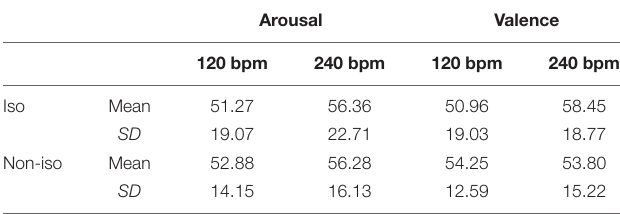
TABLE 2 | Means and standard deviations (SD) of mean arousal and valence subjective ratings according to auditory stimulation (Iso, isochronous; Non-iso, non-isochronous) and tempo (120 and 240